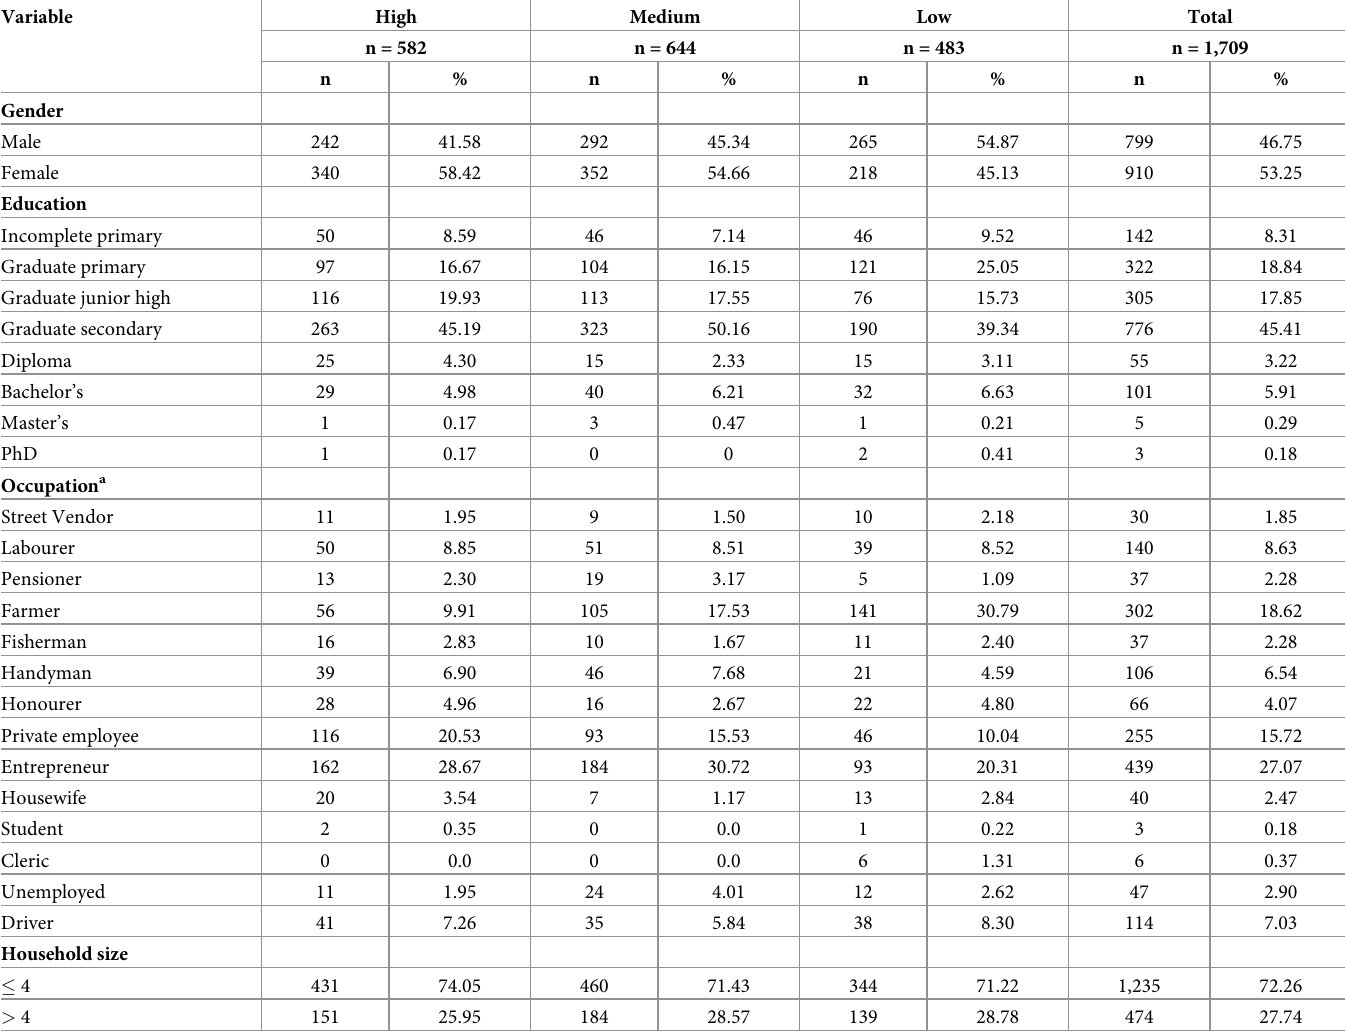
Table 2. Demographic characteristics of the respondents across district fiscal